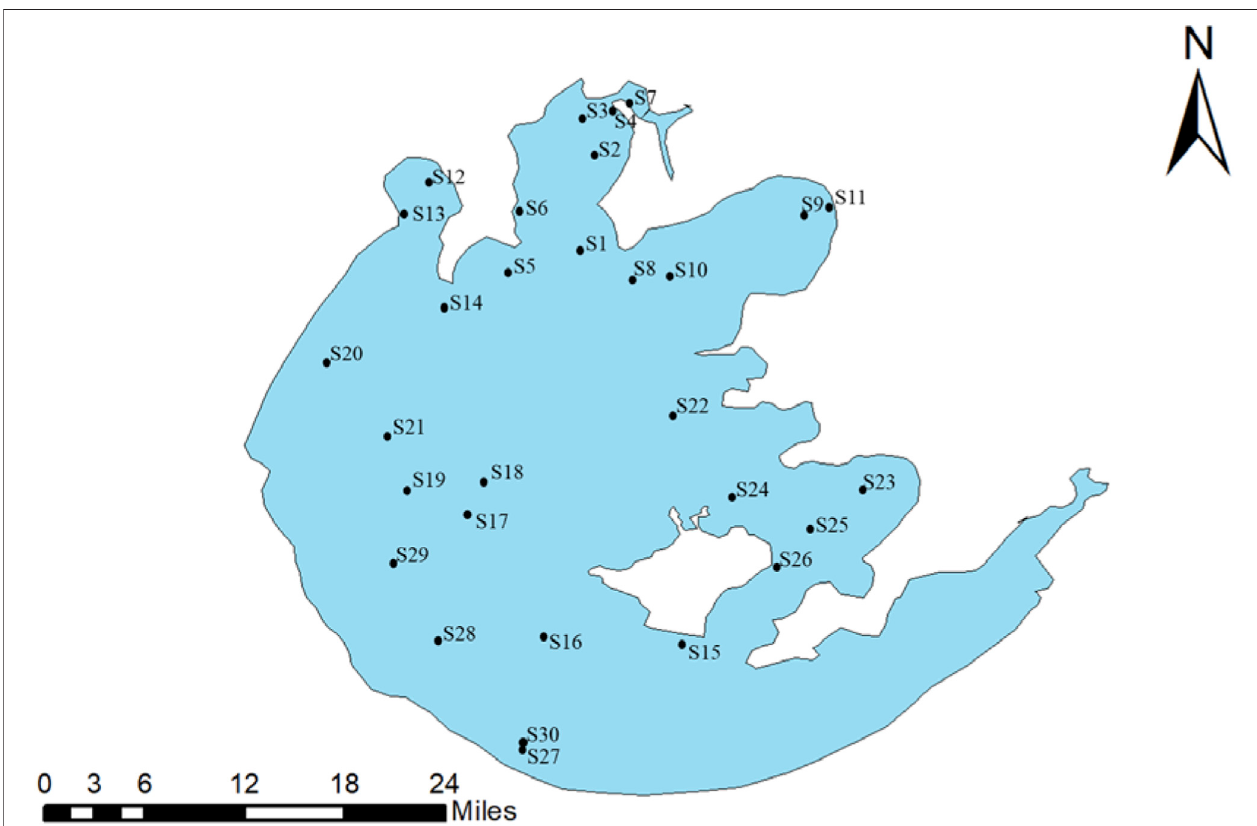
FIGURE 1 | Sediment sampling sites in Taihu